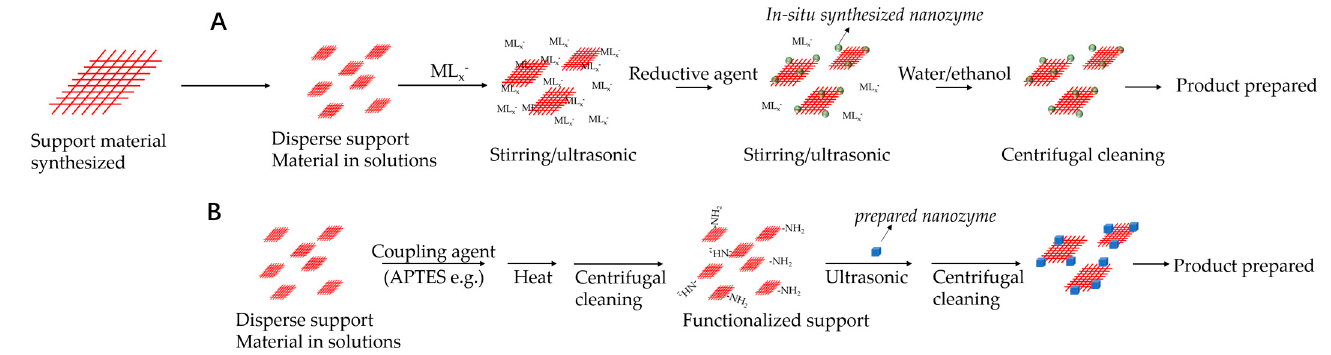
Figure 4. Typical routes to synthesis nanocomposites containing support materials and smaller nanozyme units: ( A ) the nanozyme units are grown in situ on the surface of the support materials; ( B ) the nanozyme units are pre − prepared.